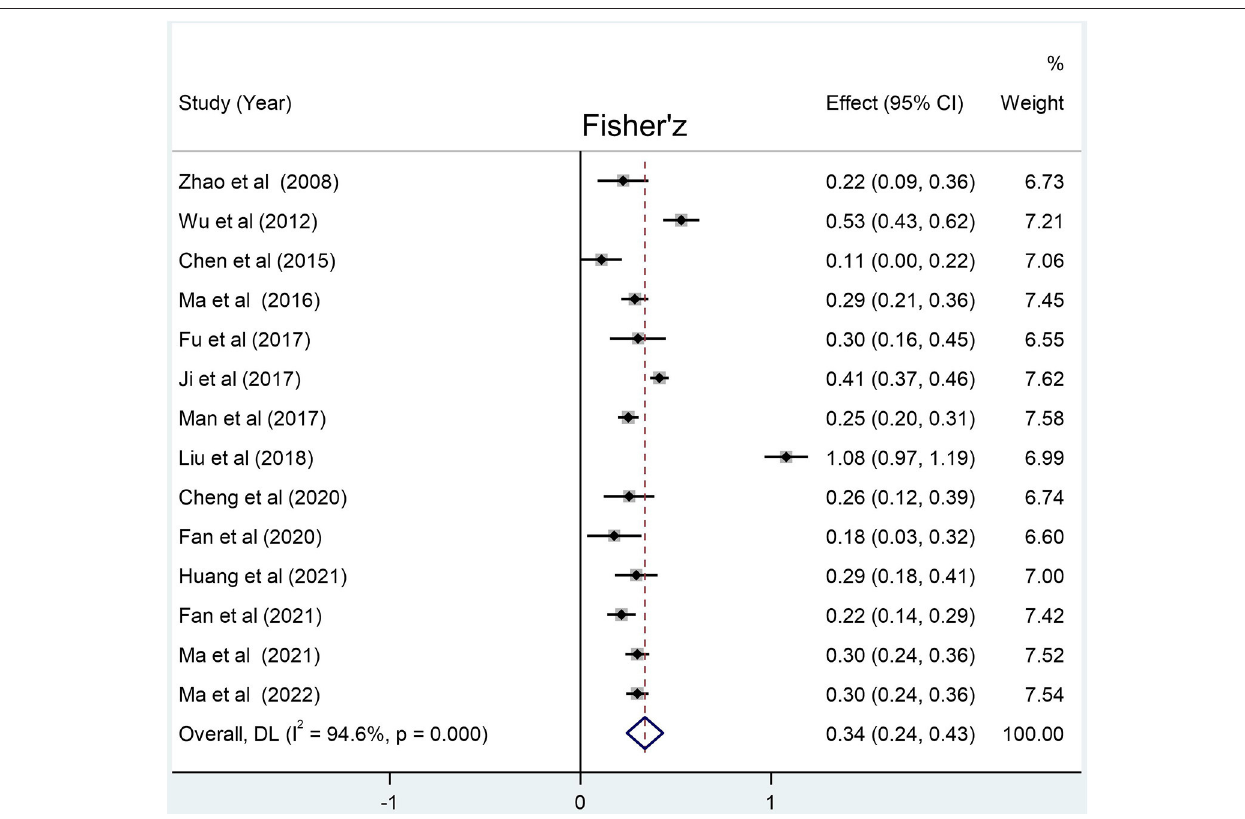
FIGURE 3 | Forest plots for the correlation between social support and self-esteem. Weights are from random-effects